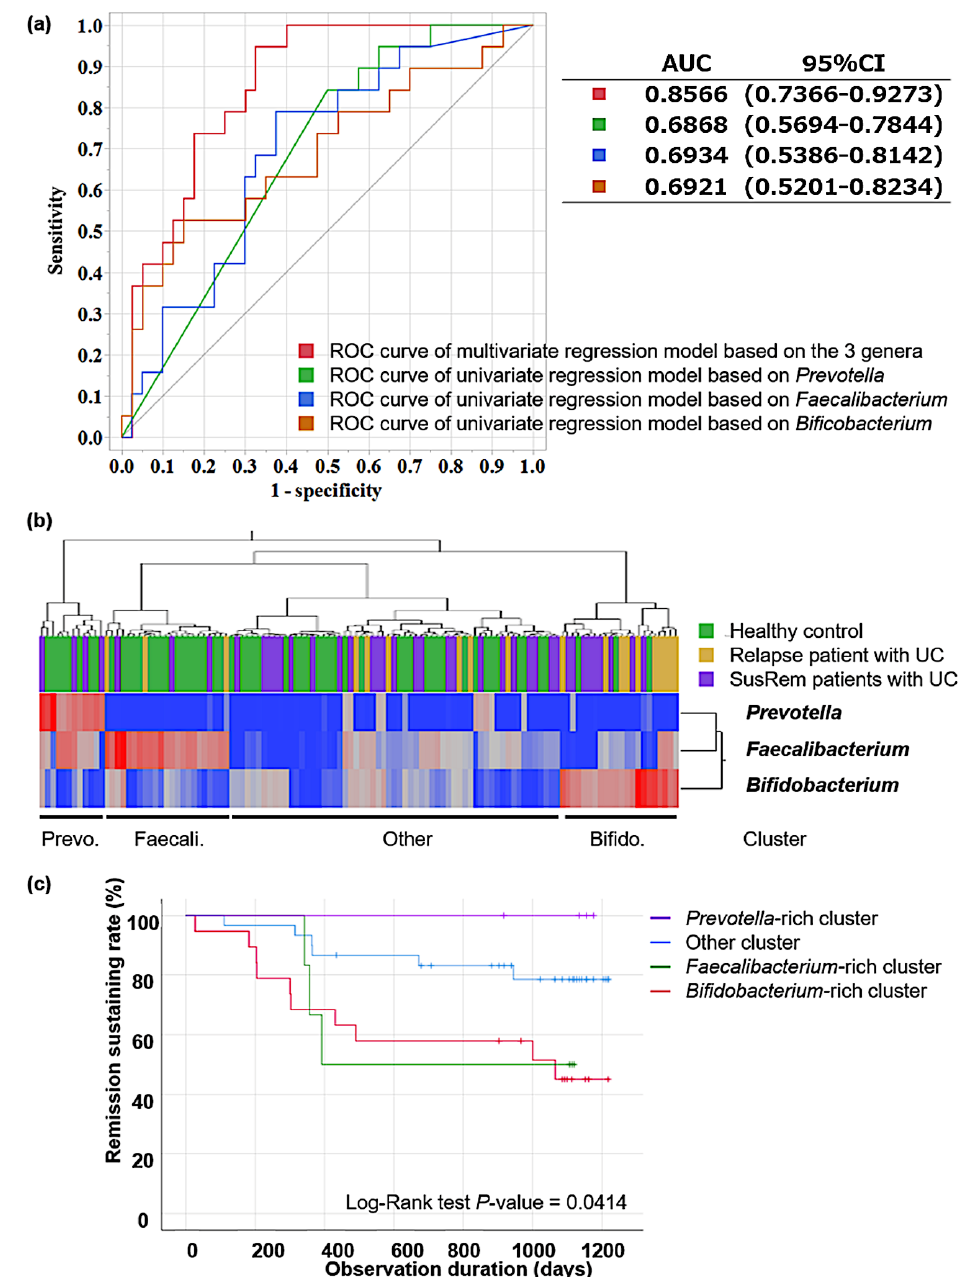
Figure 3. Comparison of predictors of ulcerative colitis relapse and clustering analysis based on the three genera, and their prognosis for relapse: ( a ) the receiver operating characteristics (ROC) curves based on multivariate logistic regression analysis with the abundance of Prevotella , Faecalibacterium , Bifidobacterium and based on univariate logistic regression analysis with each genus; ( b ) clustering analysis for the whole cohort, including quiescent ulcerative colitis patients and healthy controls via Ward’s hierarchical method based on the abundance of Prevotella , Faecalibacterium, and Bifidobacterium. In the upper section, green indicates healthy subjects, yellow indicates relapsed patients with ulcerative colitis, and purple indicates SusRem patients with ulcerative colitis. In the lower section, the abundance of each genus is indicated by color change, with red indicating high abundance and blue low abundance; ( c ) Kaplan–Meier analysis according to four clusters ( Prevotella -rich, Faecalibacterium - rich, Bifidobacterium -rich, and other clusters) and log-rank test showing differences in the clinical course of each cluster. SusRem, sustained remission; Prevo., Prevotella ; Faecali., Faecalibacterium ; Bifido., Bifidobacterium